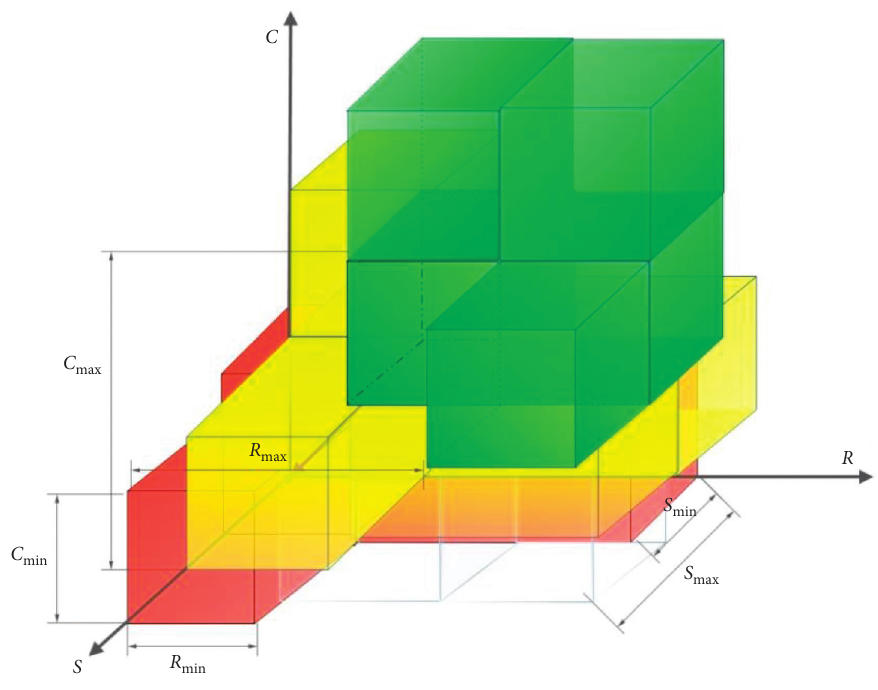
Figure 5: Three-dimensional spatial range of health degree.